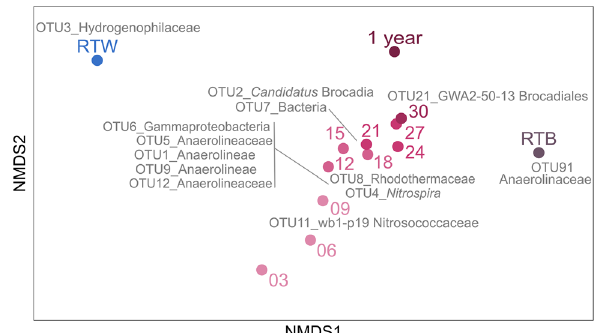
Figure 4. NMDS ordination based on Bray–Curtis distance of the bacterial OTUs from biofilm developed for years on the rock (RTB), glass slides (3–30 week and 1 year) and water samples (RTW) of the RT spring (stress: 0.03). Based on SIMPER analysis, OTUs responsible for 60% dissimilarity among samples are shown in gray. Figure is based on the combination the results of this study and Enyedi et al.